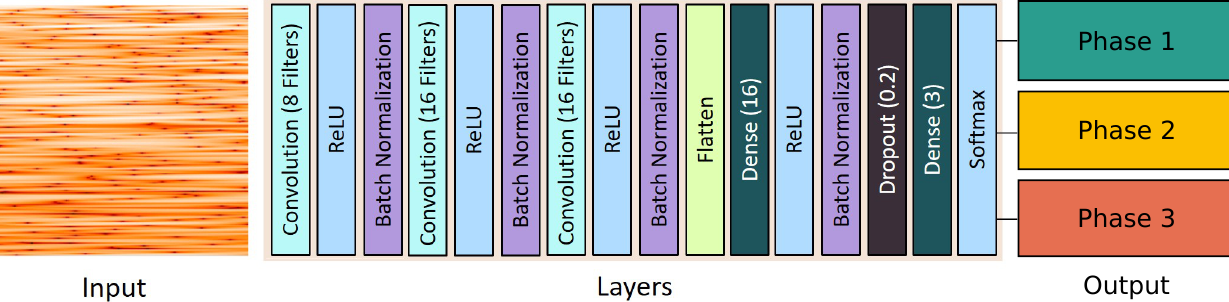
Figure 5. CNN architecture. The input is presented in the form of an image. A total of 2592 input images are used for training the network. There are three convolution layers followed by flattening, dense, dropout and dense. SoftMax has been added in the end to convert the output in terms of